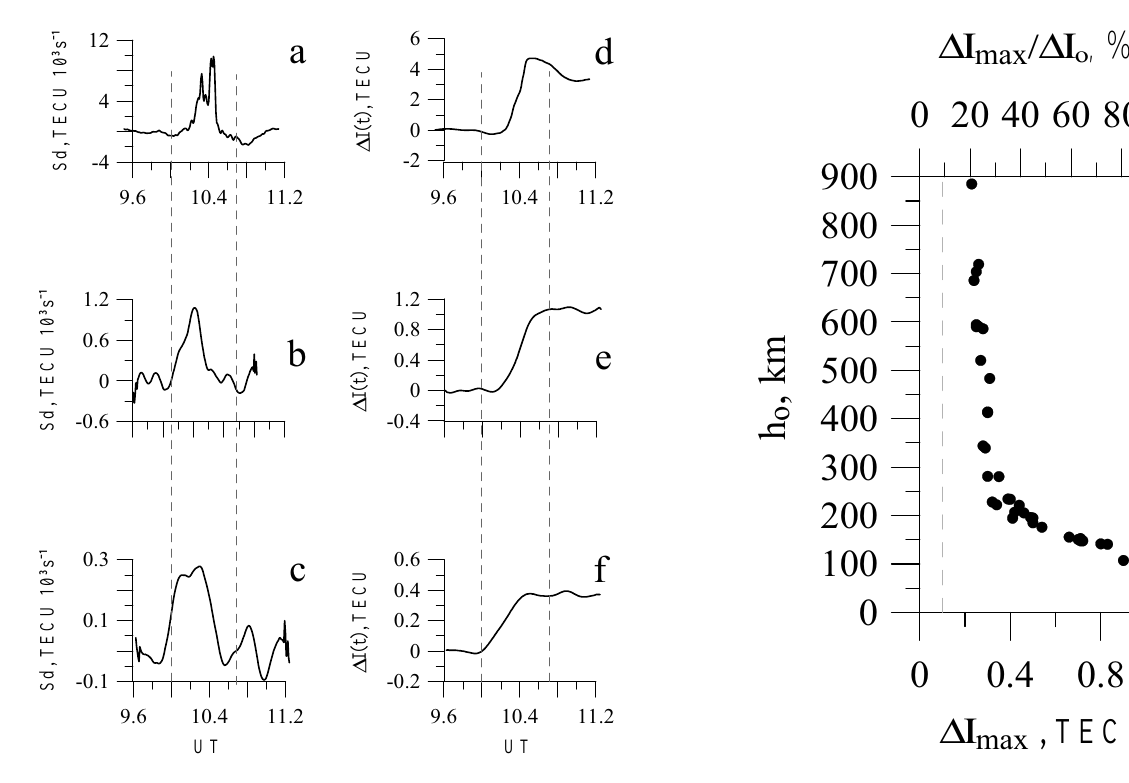
Fig. 4. Comparison of the TEC response for different conditions of atmospheric illumination. The result of a coherent accumulation of the TEC time derivatives Sd ex (a) , and the mean integral TEC increment 1I(t) (d) for stations located in the Earth’s illuminated hemisphere. Similar results for stations lying along the terminator line (b) , (e) , and for LOS crossing the shadow boundary at altitudes higher above 300km (c) , (f) . Dashed lines correspond to the start and end times of the soft X-ray flare (GOES-10, 1–8 ˚A).